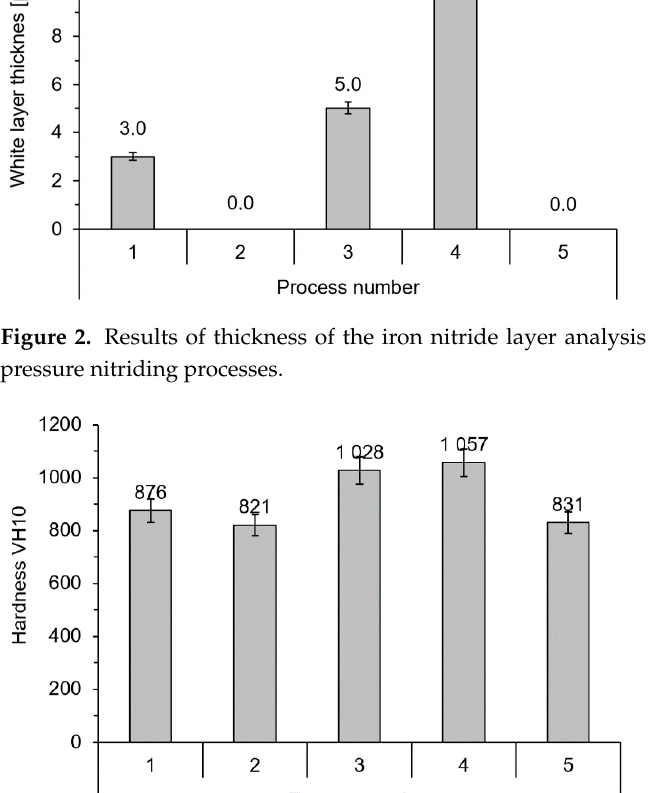
Figure 3. Results of surface hardness analysis of X37CrMoV5 ‐ 1 steel after low ‐ pressure nitriding processes.